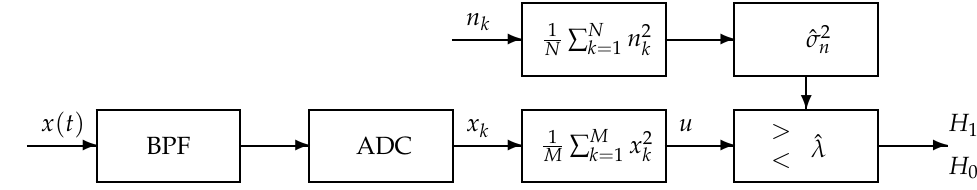
Figure 1. Energy detector using estimated noise variance by available similar channel. The noise variance is estimated by ˆ σ 2 n = 1 ∑ N k = 1 n 2 N k from other available similar channel. Then the empirical average energy u = 1 ∑ M k = 1 x 2 M k is detected by principle CFAR or CDR with the threshold ˆ λ using the estimated noise variance ˆ σ 2 n .